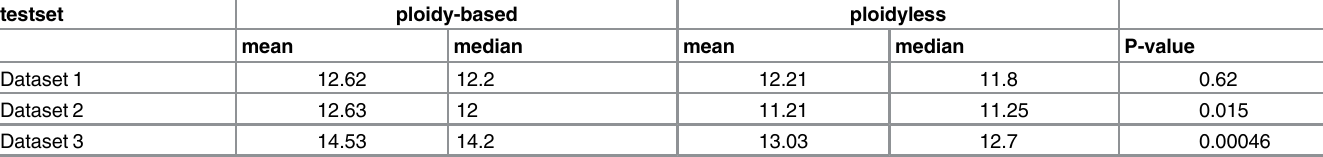
Table 2. Reconstruction error for three datasets. P-values were for a Wilcoxon paired test that the distributions are different.